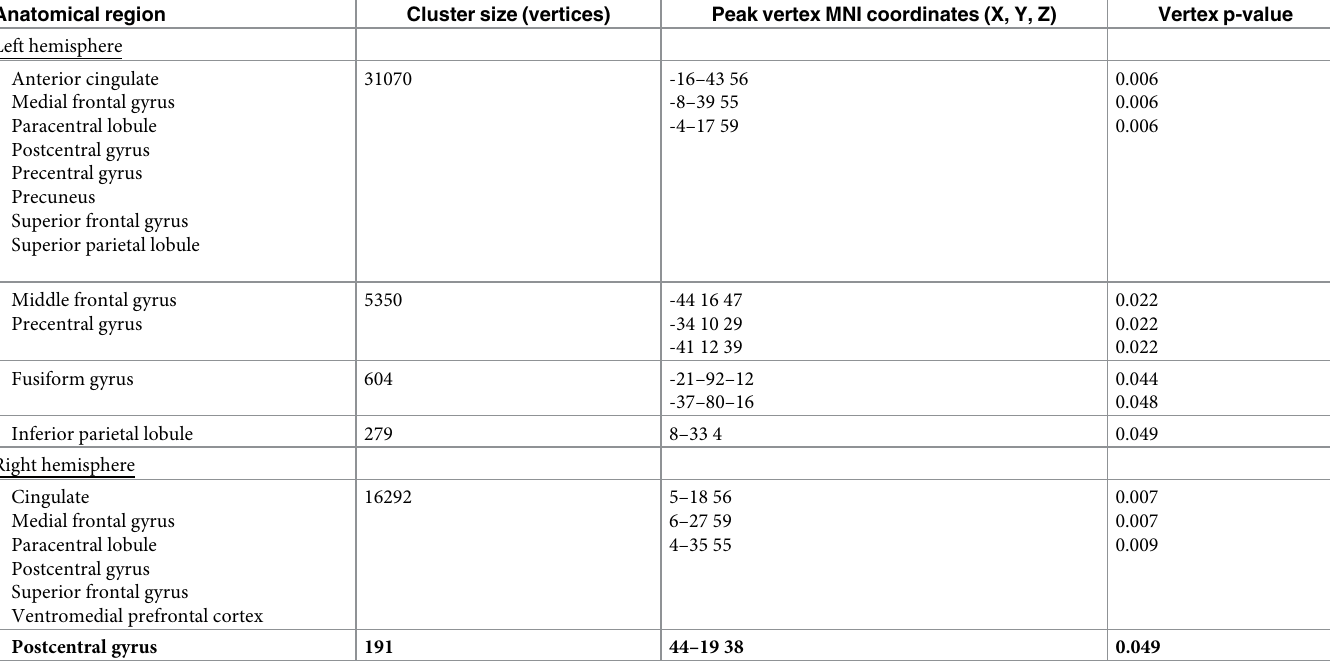
Table 3. Reduced cortical thickness in high ECAT exposure group compared to low ECAT exposure group with covariates. Anatomical region